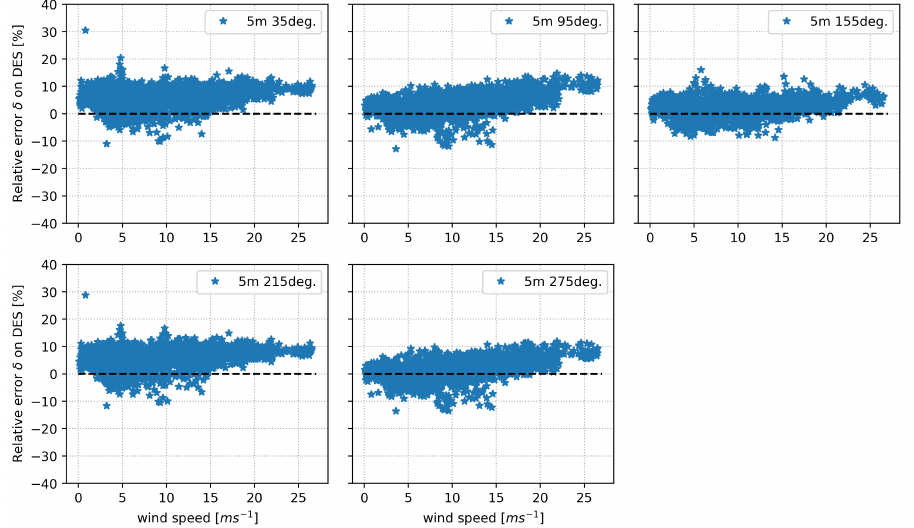
Figure A3. Relative error δ on DES for sensors on the TP.